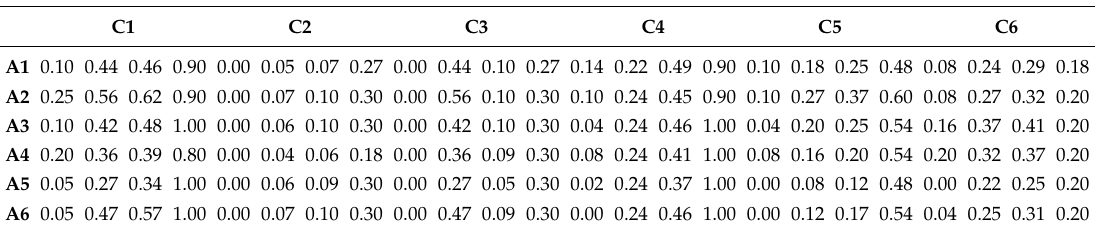
Table 10. Weighted normalized fuzzy decision matrix.